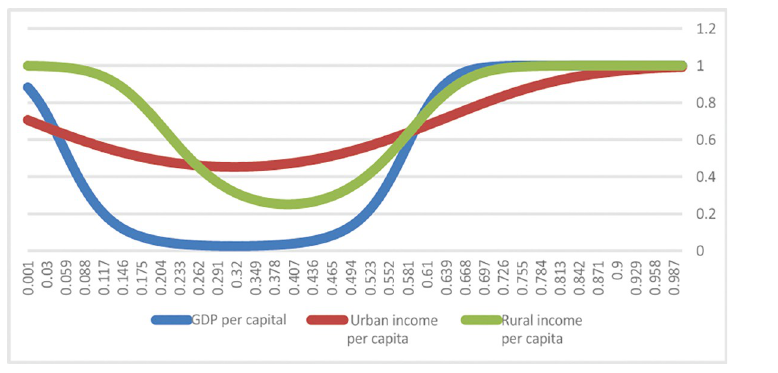
Fig 2. Transition functions under different explanatory variables in model